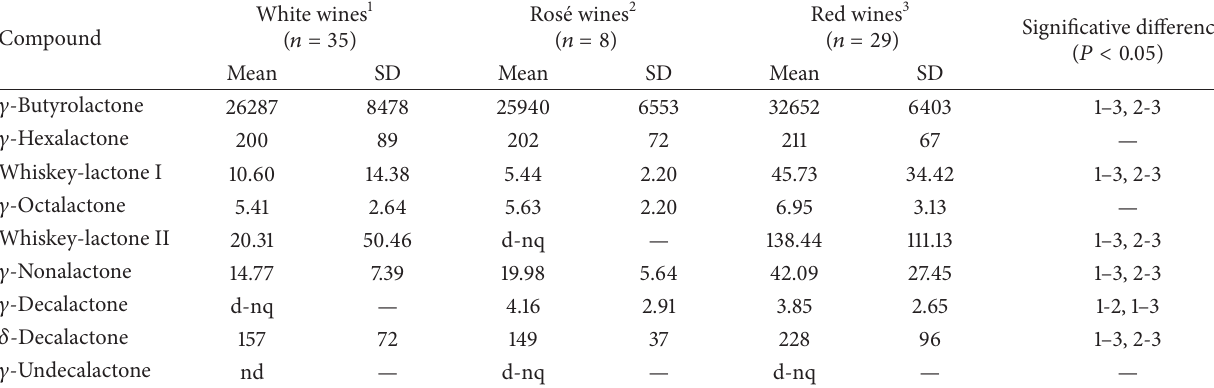
Table 9: Concentration mean and SD ( 𝜇 g/L).